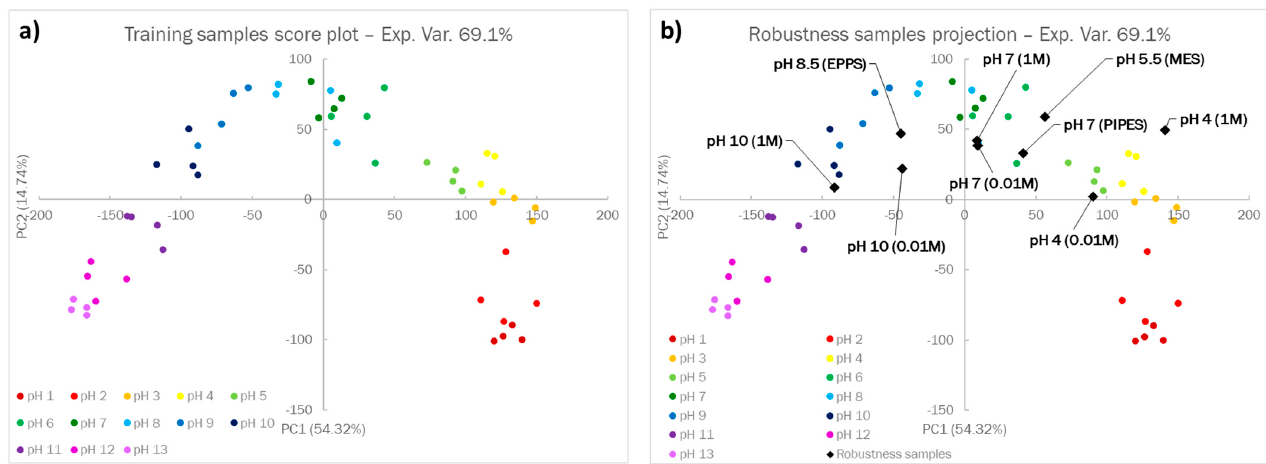
Figure 3. The score plot of the PCA model on the first two principal components, built on the train- ing set ( a ), and the projection of the robustness samples in the previously developed model ( b